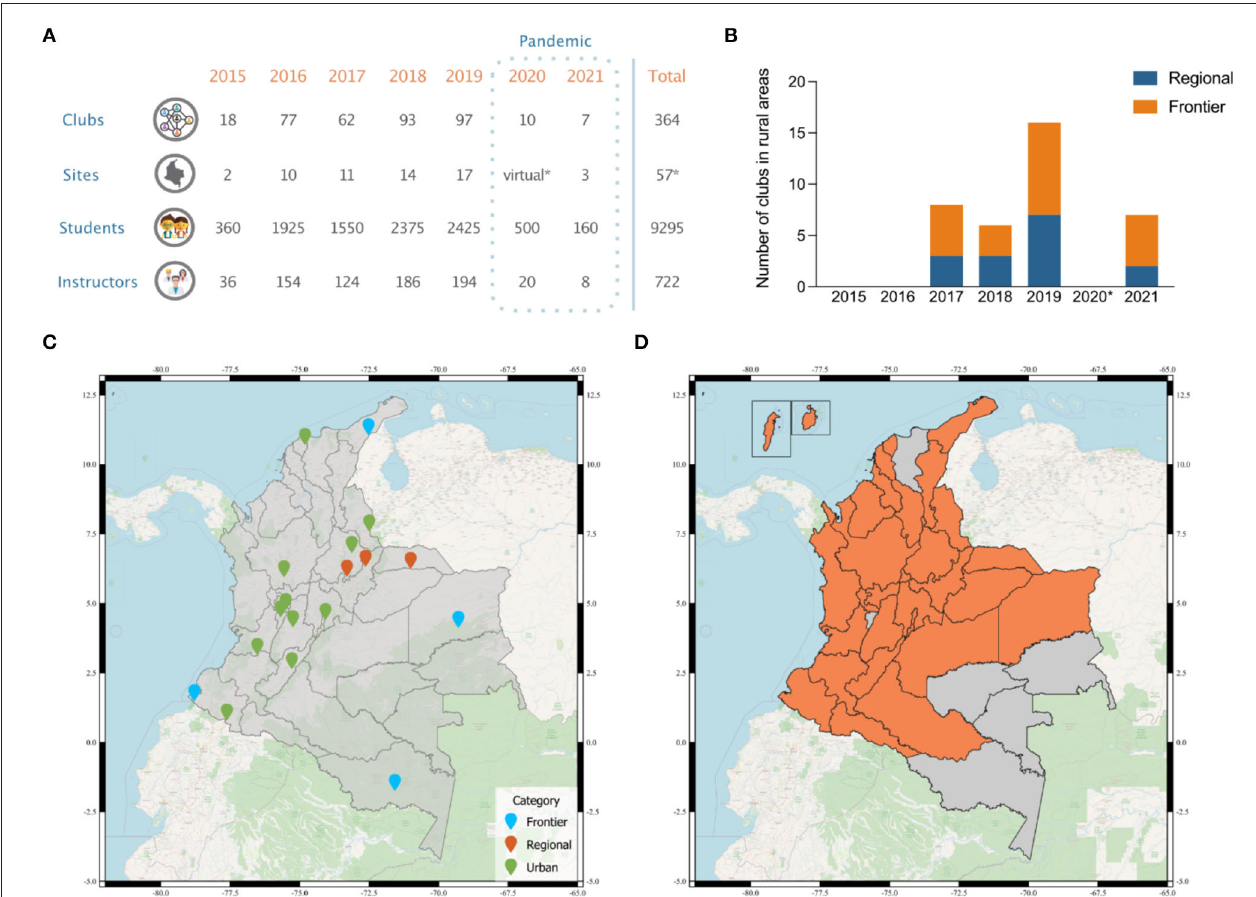
FIGURE 2 | Impact of the program (2015–2021). (A) Number of Science Clubs, participants, and sites during the seven years of the program operation in Colombia. *Denotes the virtual edition of the program that ran in 2020 due to the COVID-19 pandemic. The 2021 edition of the Program consisted of a hybrid implementation of the Clubs—“Science Calls You” edition. (B) The number of Science Clubs that have taken place in rural communities through the Regional and Frontier versions of the program. (C) Map of the geographical distribution of Science Clubs sites in Colombia throughout the history of the program. Colors indicate urban or rural (including both regional and frontier) locations. (D) Colombian departments reached during the 2020 Clubs at Home edition of the